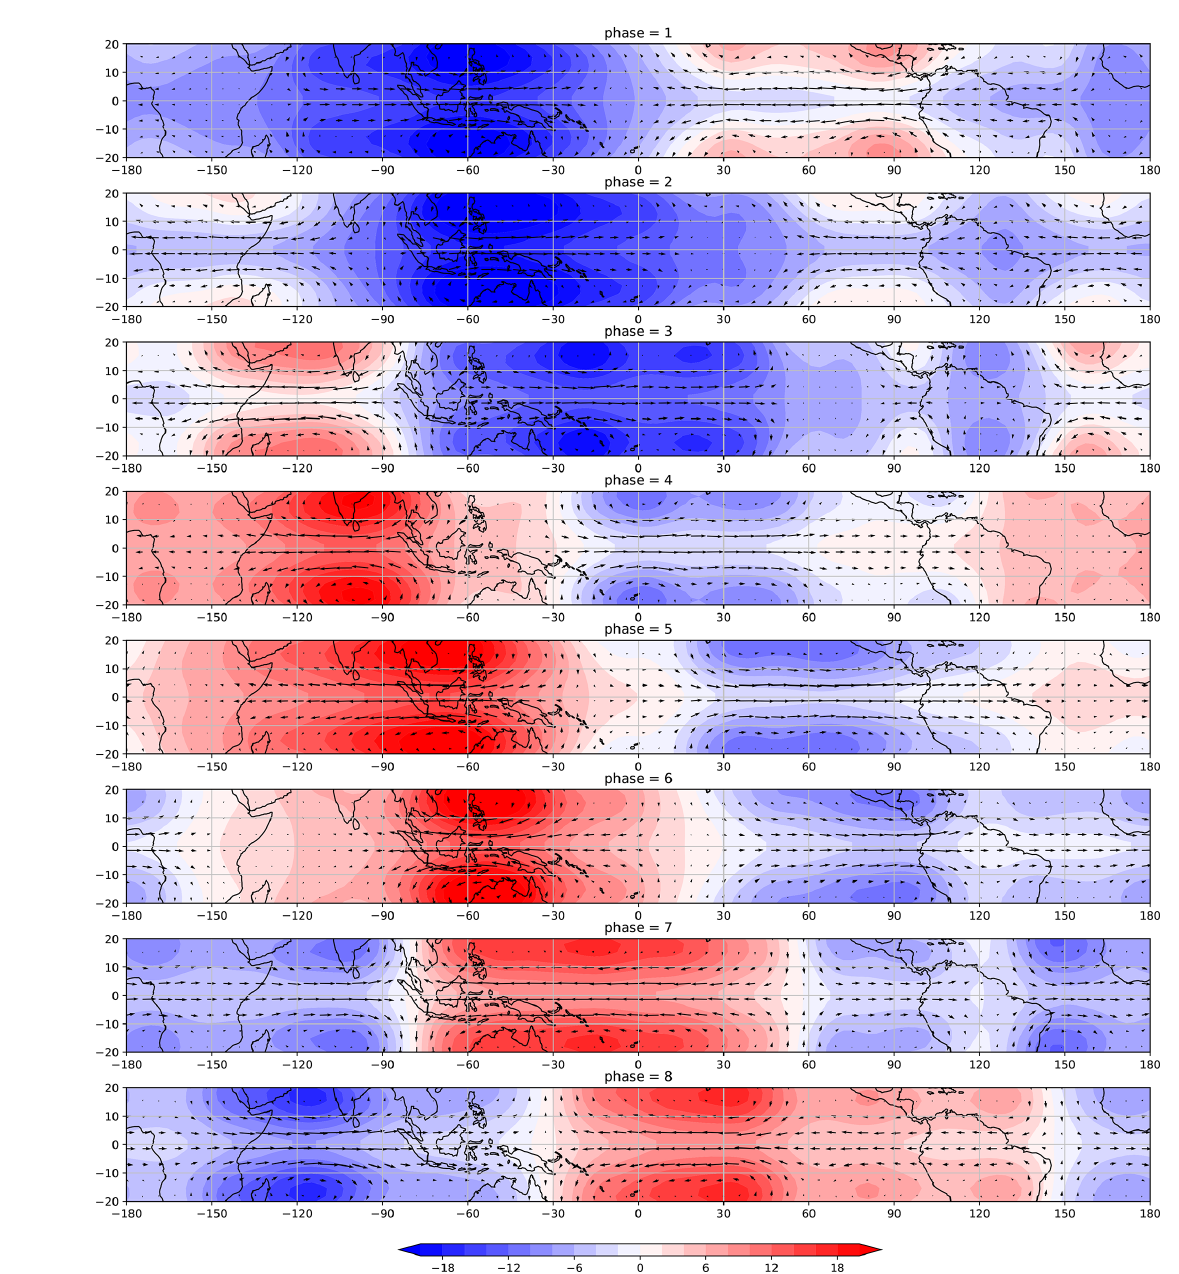
Figure 11. Reconstruction at 200Mb of the velocity and geopotential height fields associated with ROT modes with (negative stratospheric zonal wind) SZW30 −